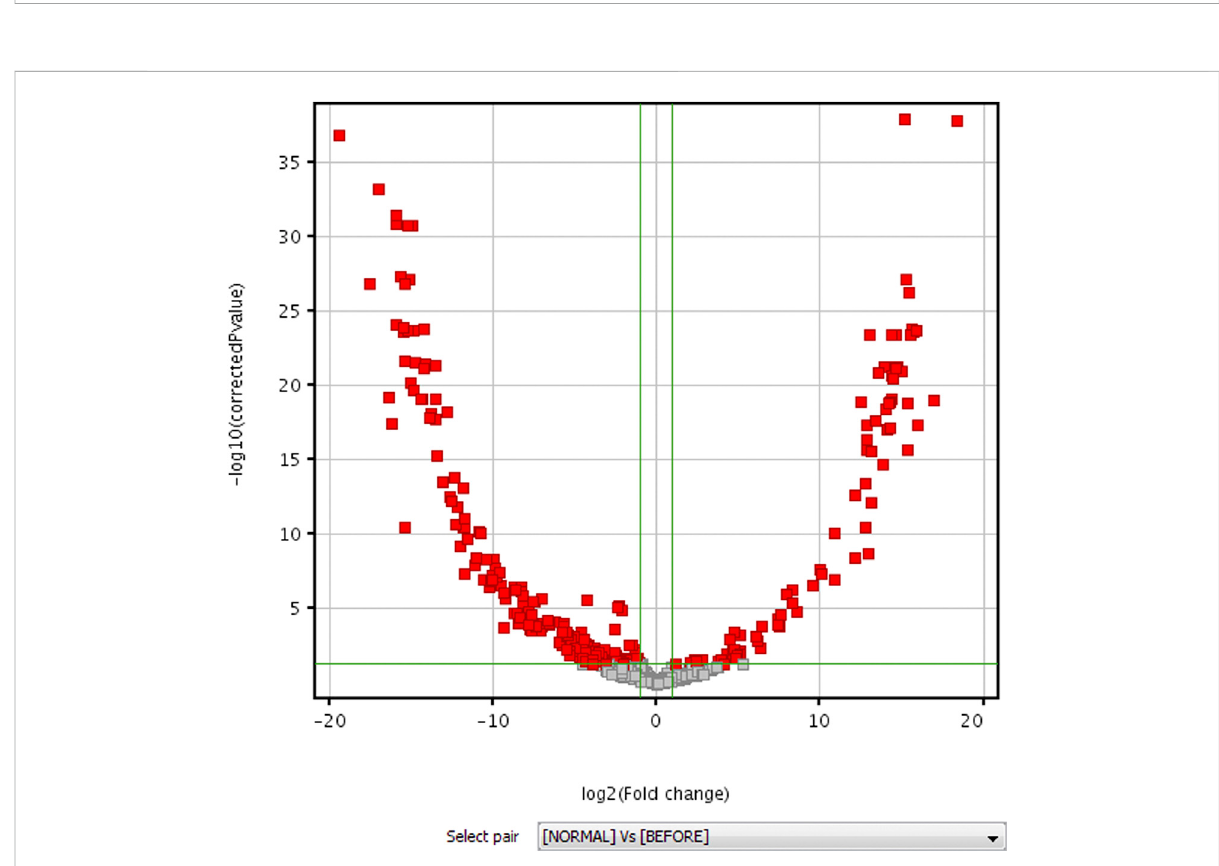
FIGURE 3 Volcano plot diagram for untargeted metabolomic pro fi ling of healthy volunteers vs patients before HAART